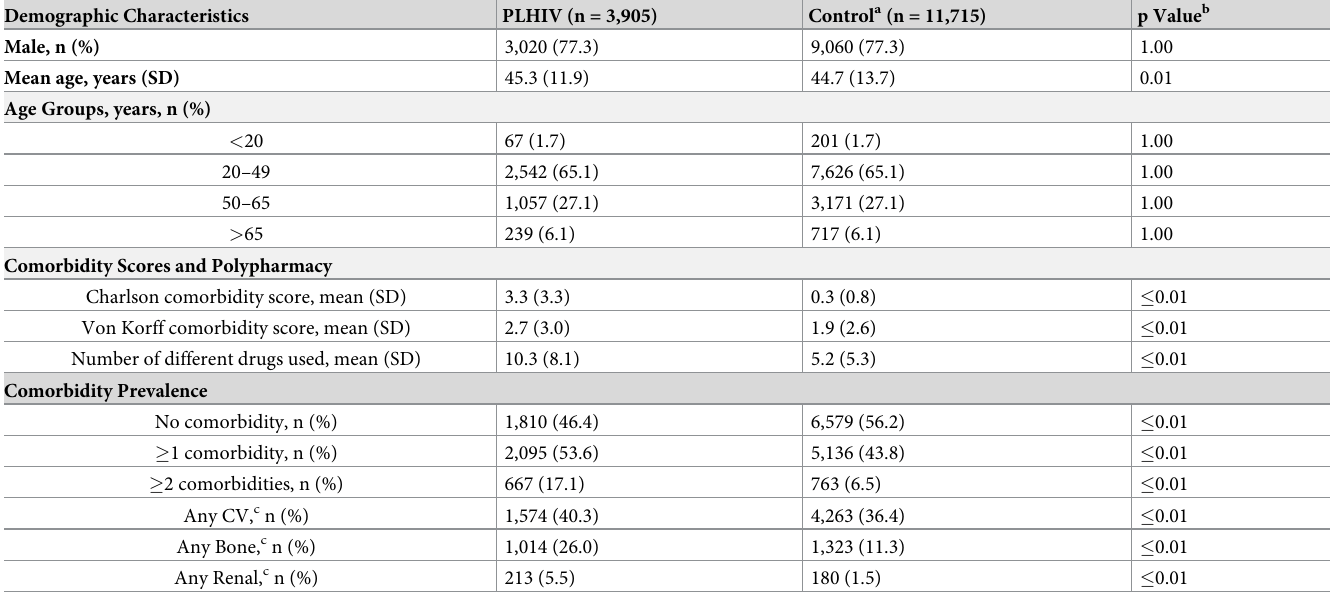
Table 1. Demographics and clinical characteristics of PLHIV and